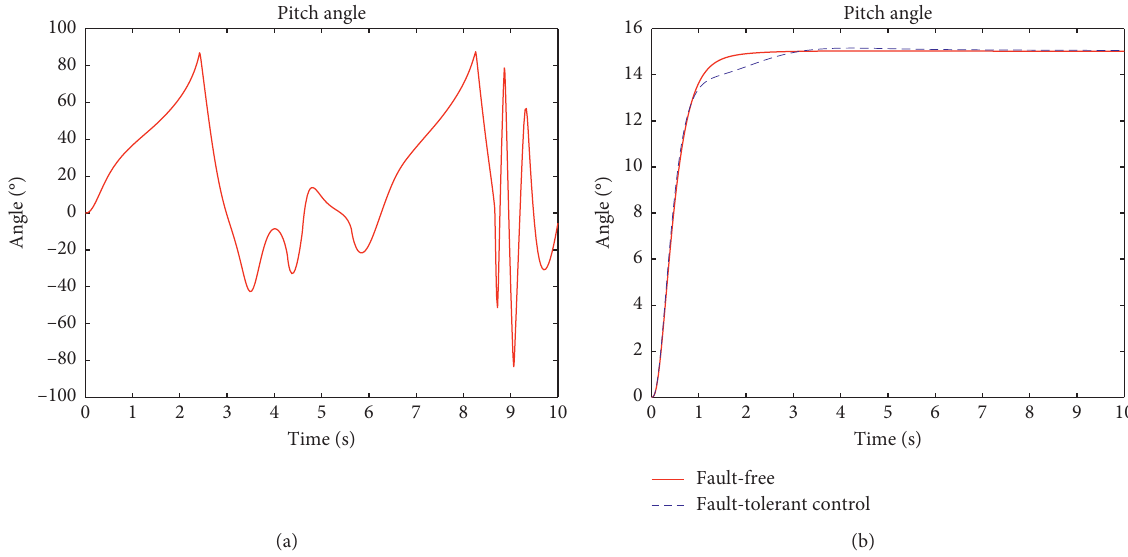
Figure 4: Comparison diagram of the pitch angle before and after fault-tolerant control. (a) Non-fault-tolerant control. (b) Fault-tolerant control.